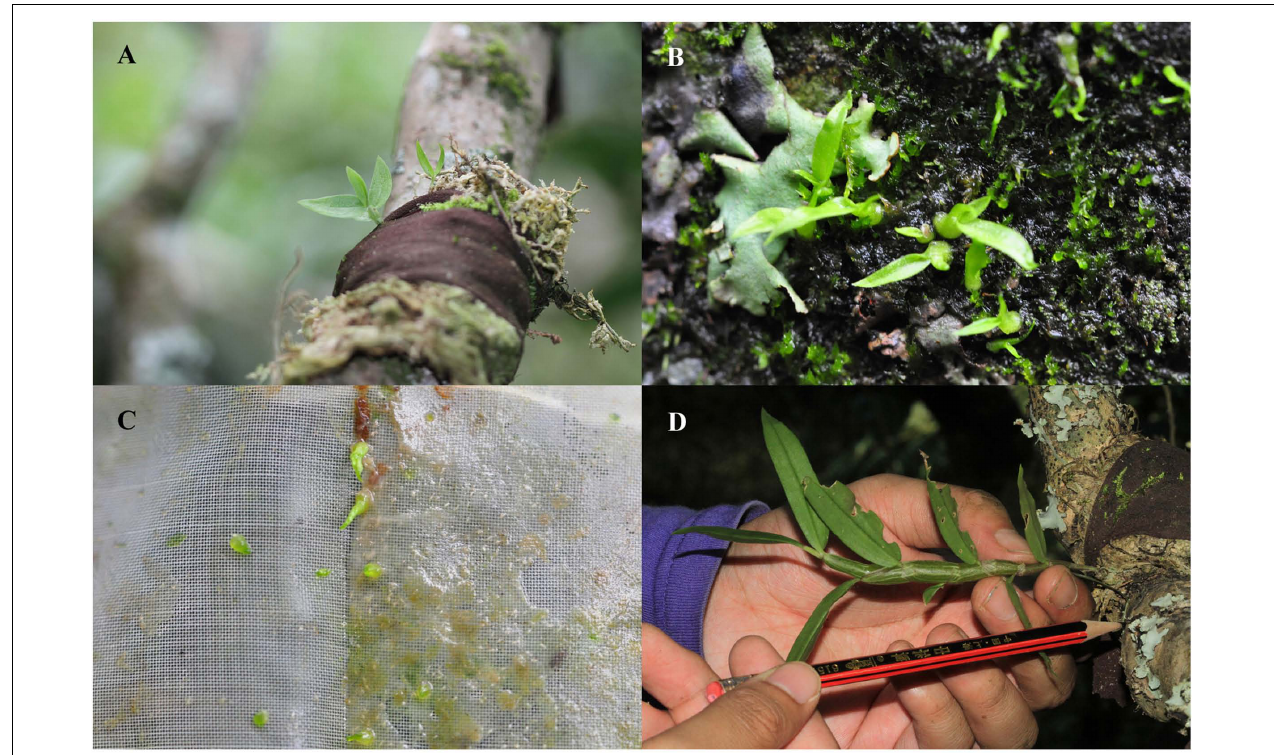
FIGURE 4 | Results of in situ symbiotic seed germination for D. devonianum in Yunnan, China. (A) Two-month old seedlings using the Sphagnum treatment in Longpa. (B) Seedlings formed by the Plastic Wrap treatments in Longpa 45 days after sowing. (C) Seedlings formed by the Plastic Wrap + packet treatments in Yiwu 30 days after sowing. (D) Twelve-month old seedlings grew to 10 cm after sowing using the Sphagnum treatment in the Longpa site, Yunnan, China.